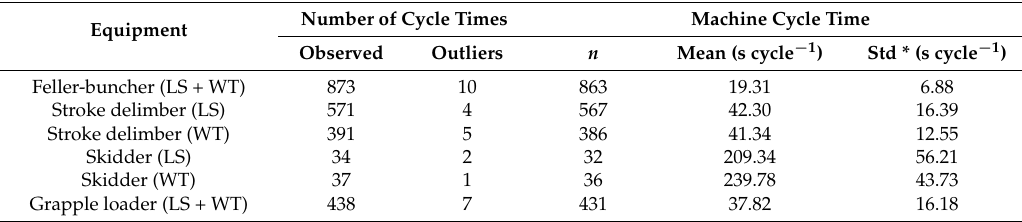
Table 4. Mean delay-free cycle times observed by harvesting equipment in lop and scatter (LS) and whole-tree harvesting (WT).